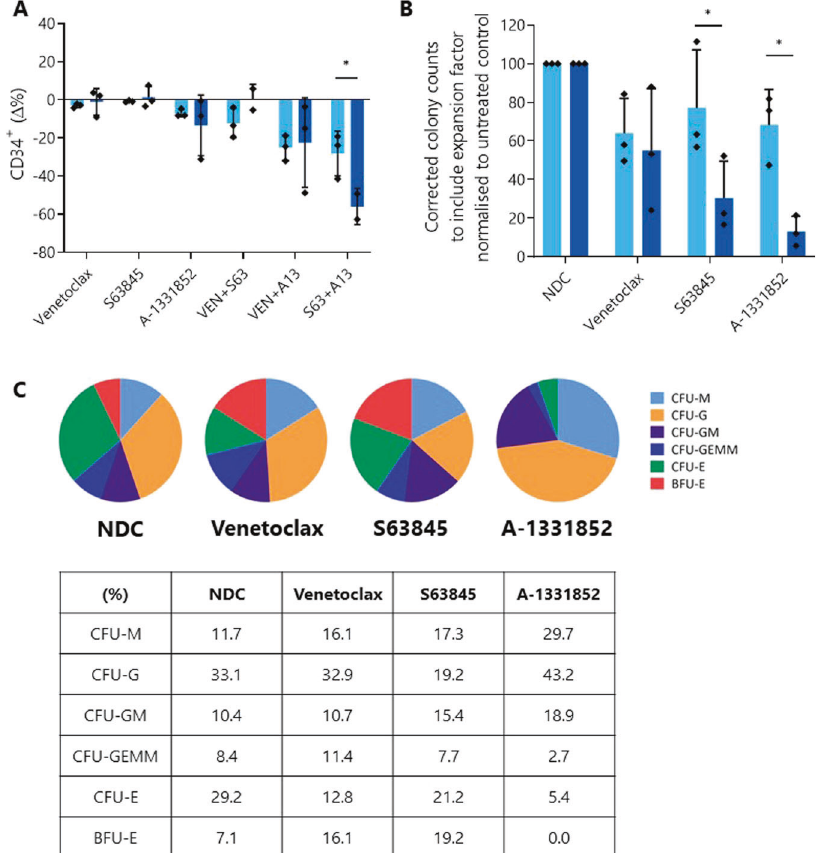
Fig. 5 BH3 mimetic treatment reduces the number of primitive cells and the colony-forming capacity of myeloid BP-CML patient samples to a greater degree than healthy samples. A Three healthy (light blue) and three myeloid BP-CML patient (dark blue) samples were treated with 1 µM indicated BH3 mimetic for 72 h and the effect on overall percentage CD34 + fraction was measured and expressed as a change from the no drug control. B Cells from three healthy (light blue) and three BP-CML (two lymphoid, one myeloid; dark blue) samples pre-treated with 1 µM BH3 mimetics for 72 h were plated in Methocult ™ and colonies enumerated and normalized to the no drug control (NDC). C Representative distribution of colony types (lymphoid BP-CML sample) can be seen as a percentage of total for each arm. Analyzed by two- way ANOVA, * p ≤ 0.05. Data are represented as mean ±